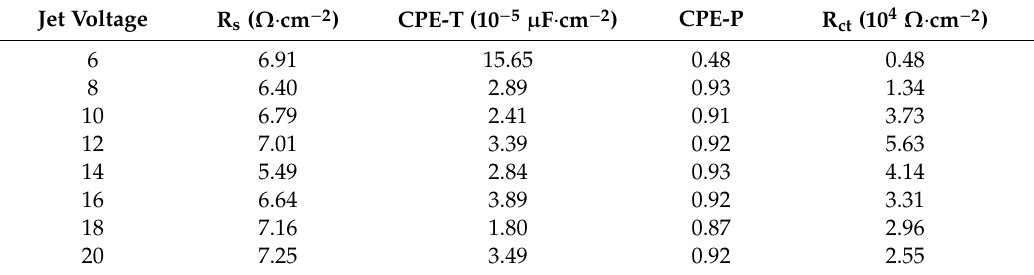
Figure 12. Equivalent circuit model of Ni–Co–P alloy coatings in artificial seawater. Table 7. Impedance spectrum fitting value of Ni–Co–P alloy coatings at di ff erent jet